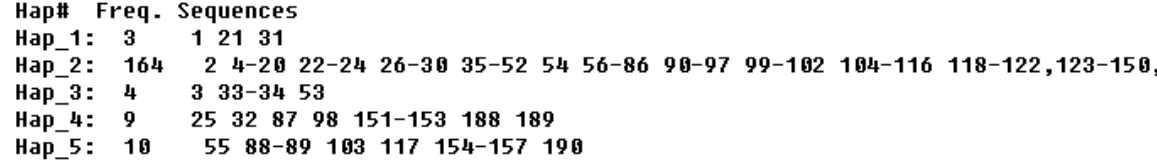
Figure 2. Haplotype frequency sequences of cytochrome oxidase I gene in gener ations 0, 5, 10, 15, 16, 17 of Langshan conservation population. Table 4. The haplotype diversity, K and Pi of COI gene for the Langshan conservation population No. of No. of Haplotype Generation individuals haplotypes